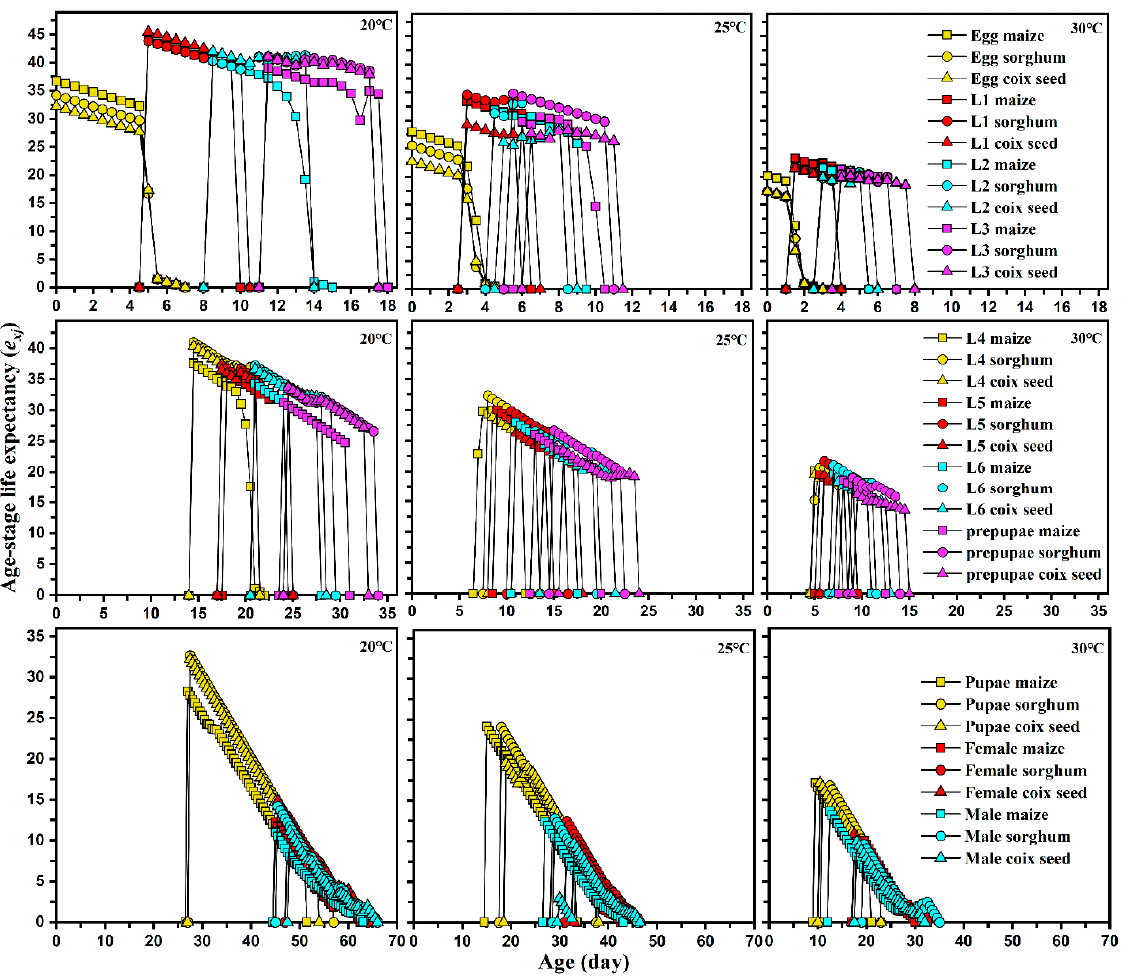
Figure 3. Age-stage specific life expectancy ( e xj ) of each development stage of Spodoptera frugiperda reared on different hosts at different temperatures.